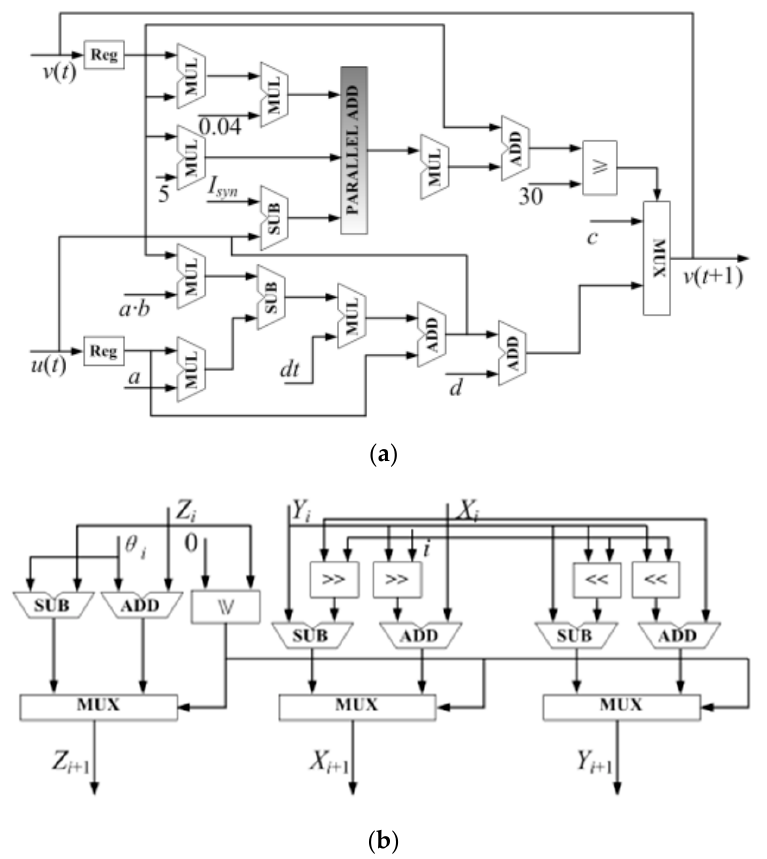
Figure 3. Digital implementation of the single neuron. ( a ) Digital implementation of the Izhikevich model; ( b ) Digital implementation of the coordinate rotation digital computer (CORDIC) algorithm.